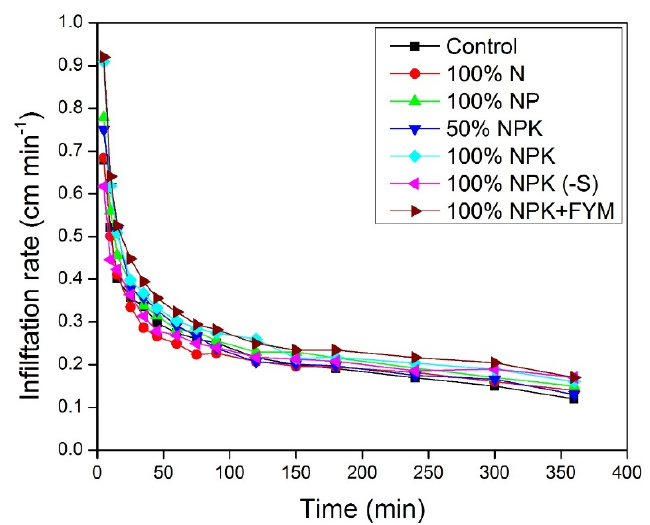
Figure 2. Change in infiltration rate with time among different fertilizer treatments. Means for infiltration rates were statistically significant at P ≤ 0.05.